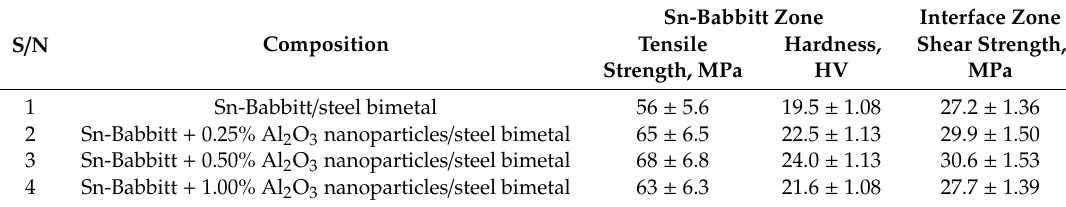
Table 2. Tensile strength, hardness and shear strength of tin-based Babbitt / carbon steel bimetal with without Al 2 O 3 nanoparticles additions.